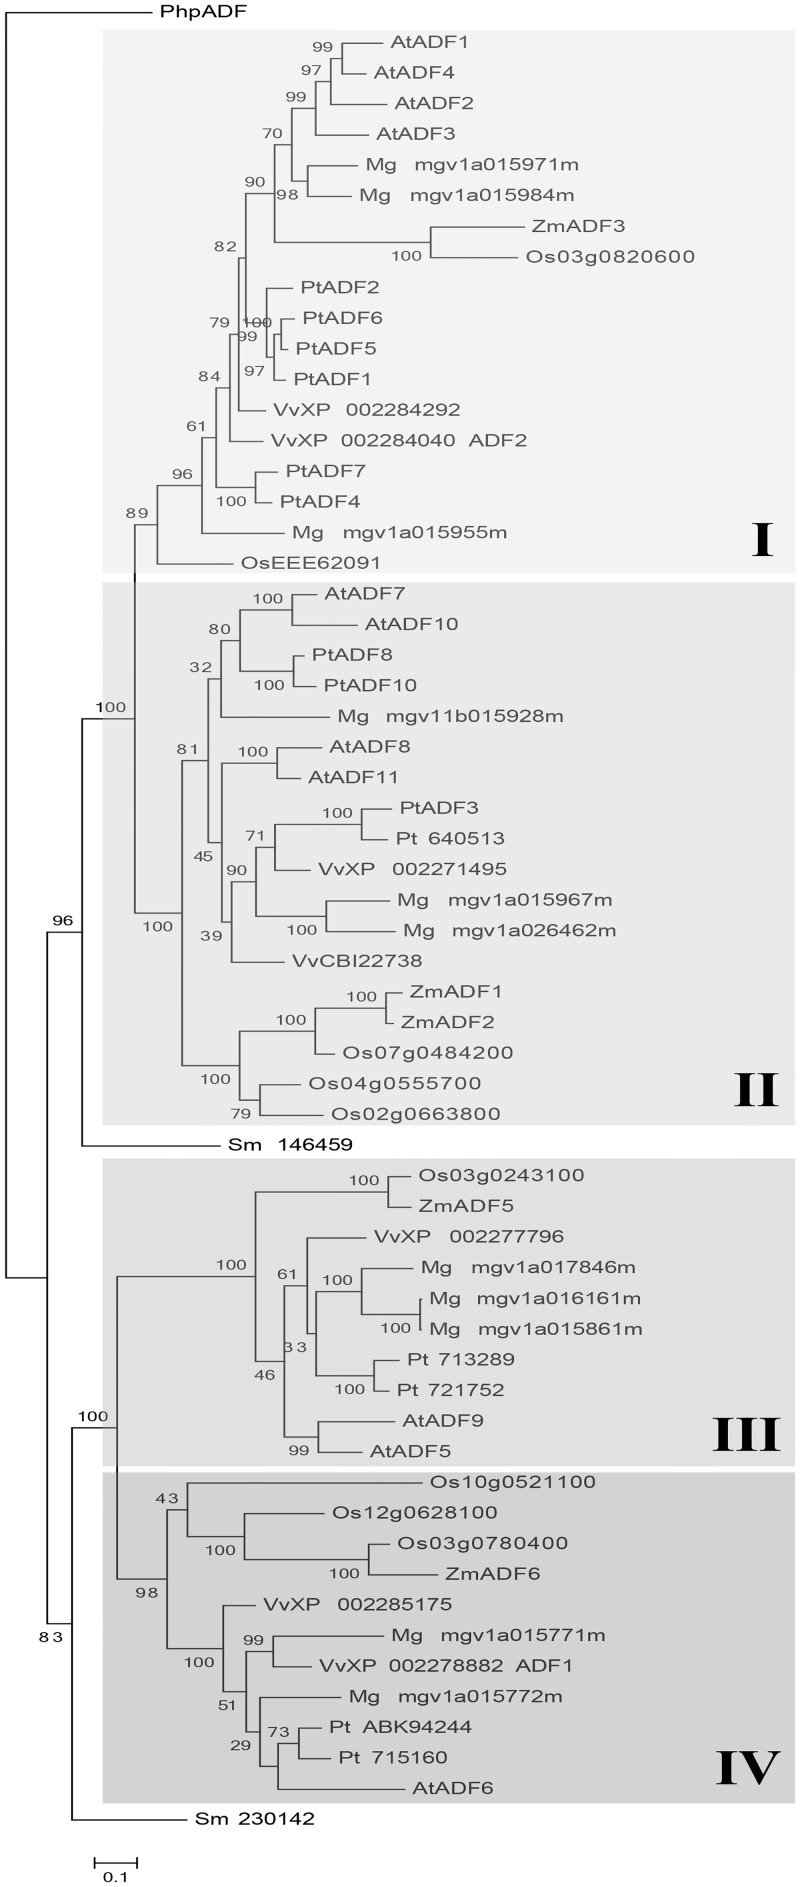
Bayesian phylogenetic analysis of the plant ADF gene family.The four ADF subclasses are highlighted in boxes. Species designations are as follows: At, Arabidopsis thaliana; Pt, Populus trichocarpa; Mg, Mimulus guttatus; Vv, Vitis vinifera; Os, Oryza sativa; Zm, Zea mays; Sm, Selaginella moellendorffii; and Php, Physcomitrella patens. ADF family number is given next to species designation when available. For those sequences that did not have a published family number on NCBI, the accession number is given. Accession numbers for all plant ADF variants used in analyses can be found in S1 Table.